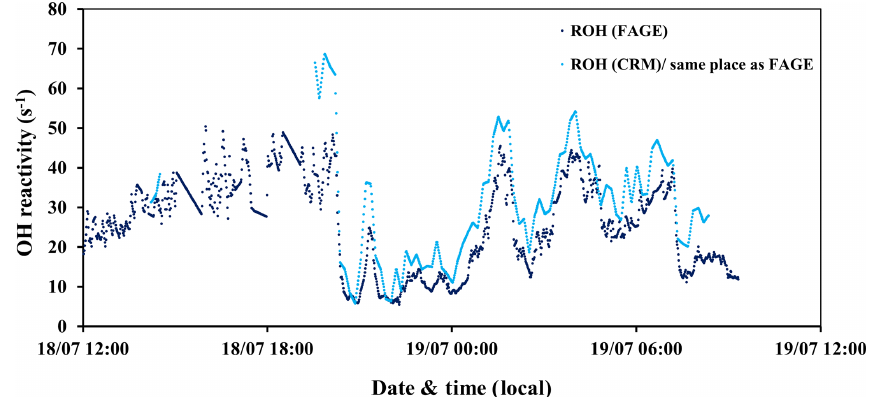
Figure 2. Time series of total OH reactivity measured by the UL-FAGE (dark blue) and LSCE-CRM (light blue) instruments from 18 to 19 July 2017 at the same location inside the canopy.